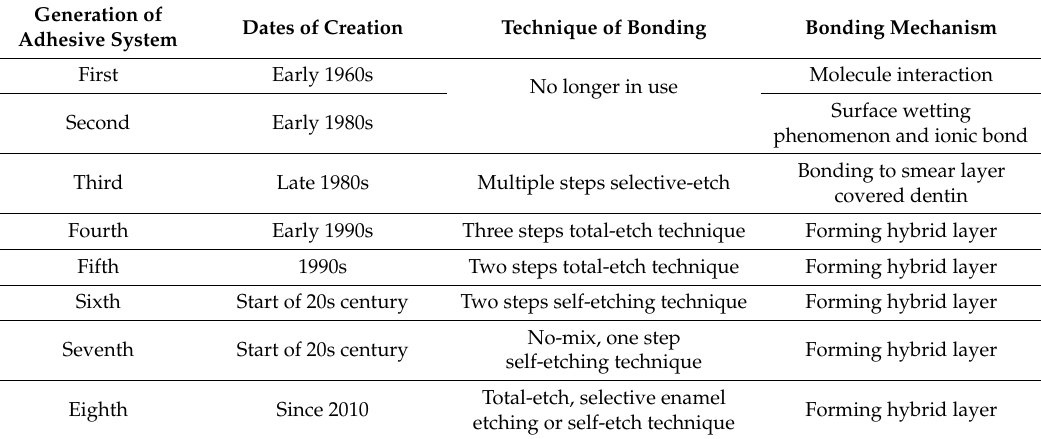
Table 1. Development of dentin adhesives.